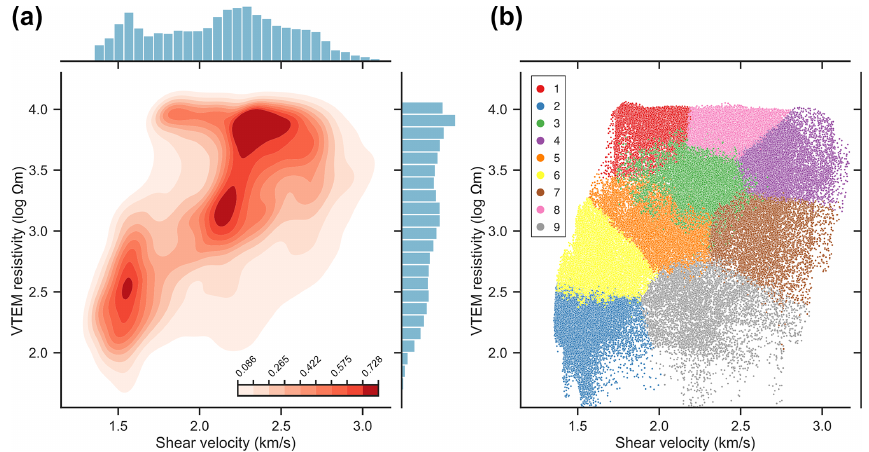
Figure 8. (a) Bivariate kernel density estimate (KDE) contour plot and marginal histograms of seismic velocity versus resistivity. (b) Scat- terplot of seismic velocity versus resistivity showing class labels of classification.